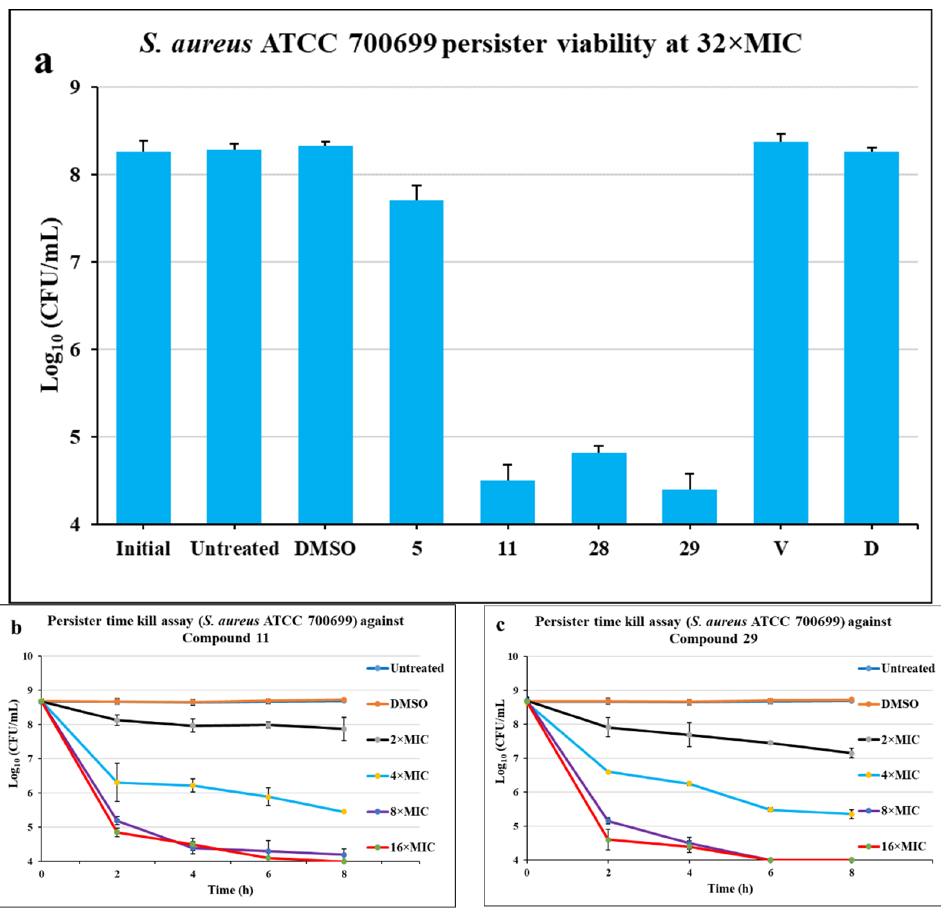
Figure 4. The activity of potent compounds against MRSA persisters. ( a ) Persister viability assay at 32× MIC for each compound run for 4 h. Persister Time Kill Assay against ( b ) compound 11 and ( c ) compound 29 at various MIC values run for 8 h. The error bars represent the standard deviation of the colony count performed in triplicates for each treatment, n = 3.